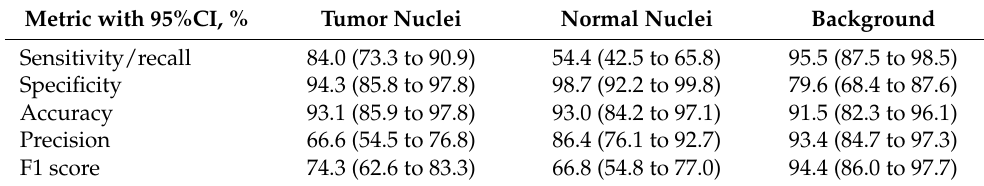
Table 6. Segmentation Performance of Neural Network (CNN TB ) for Each Individual Class.